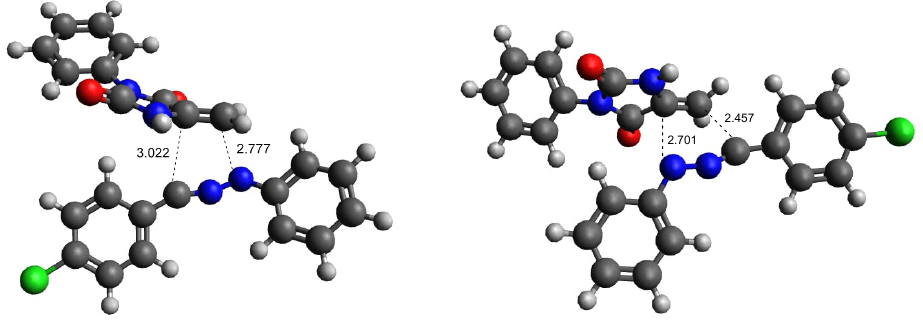
Figure 2. TS-I and TS-II calculated geometries.